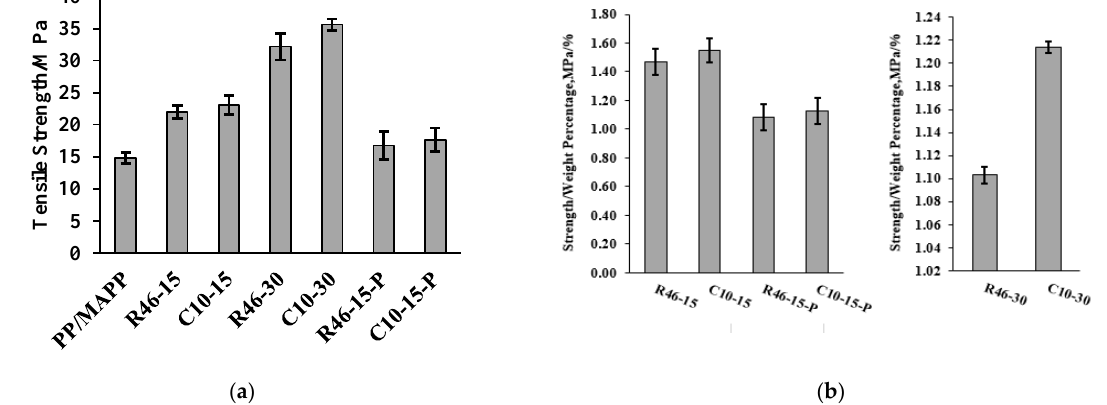
Figure 14. Graphs representing: ( a ) tensile strength and ( b ) tensile strength/weight percentage* of various composites tested. Weight percentage = weight percentage of fibres.